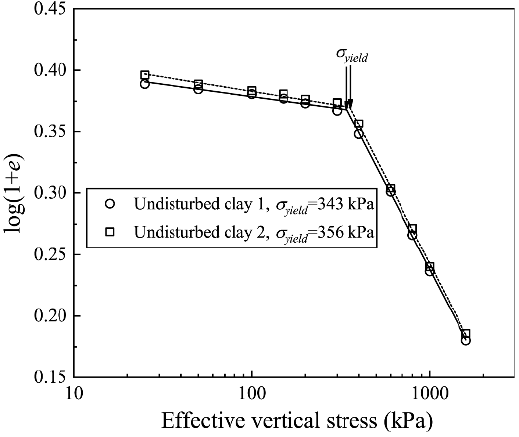
Figure 2. Typical compression curves of undisturbed Zhanjiang clay in the log(1+ e ) – log( σ’ v ) plot.